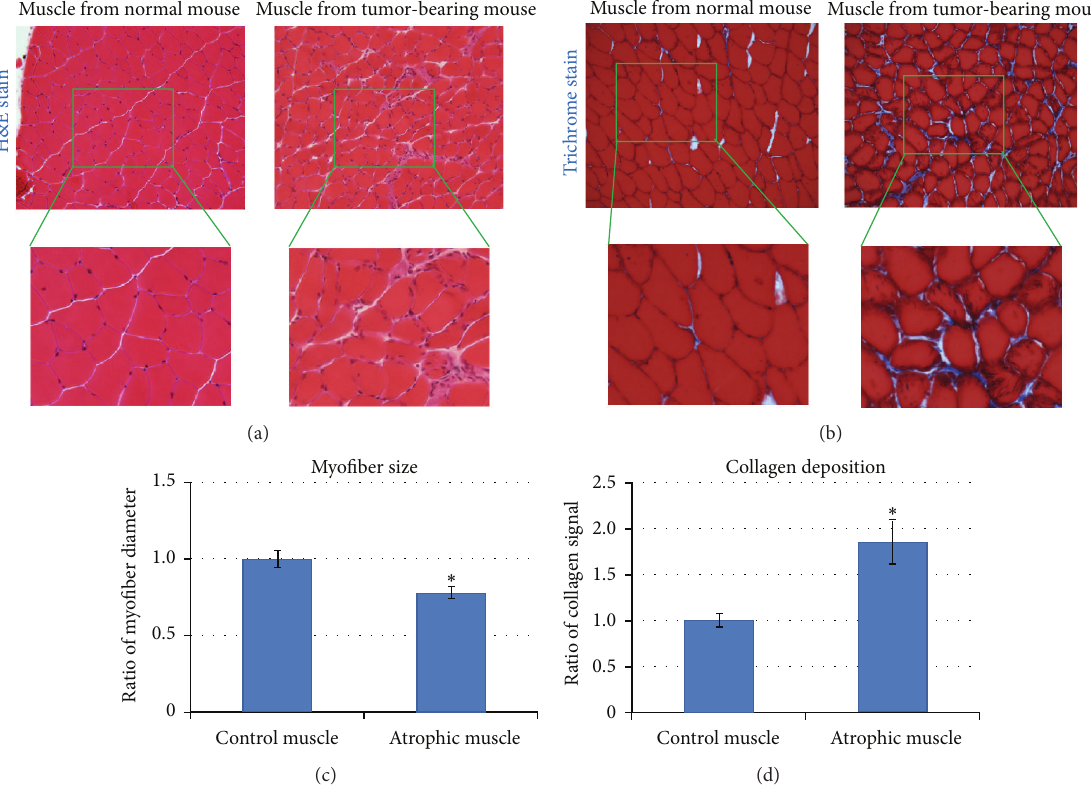
Figure 2: Skeletal muscle from tumor-carrying mice developed muscle atrophy. (a) H&E staining of GM muscles, revealing relative myofiber size and number of mononuclear cells (i.e., macrophages or undifferentiated muscle stem cells) in mice with and without tumor. 𝑁 = 4 mice in each group. (b) Trichrome staining of GM muscles, demonstrating differential myofiber size and collagen deposition. 𝑁 = 4 mice in each group. (c) Myofiber size in GM muscles. (d) Collagen deposition in GM muscles. “ ∗ ” in the bar chart indicates 𝑃 < 0.05